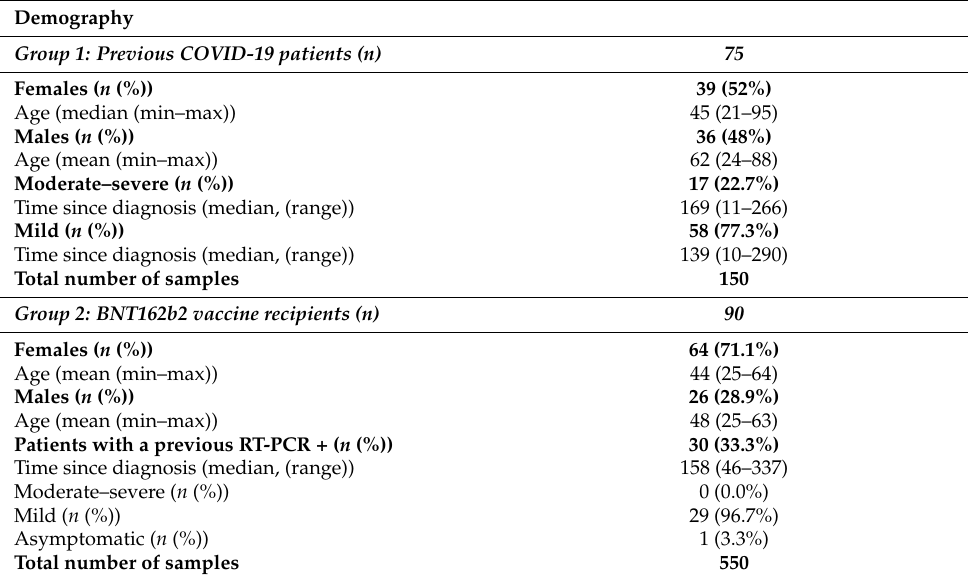
Table 1. Demographic data for (1) the past-COVID-19 group and (2) the vaccinated group. The difference between the total number of samples and the number of patients/subjects is explained by multiple timepoints for blood